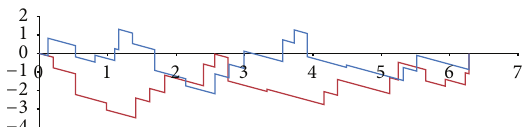
Figure 21: The periodical angle functions of the “Giraffe” for two different starting points.